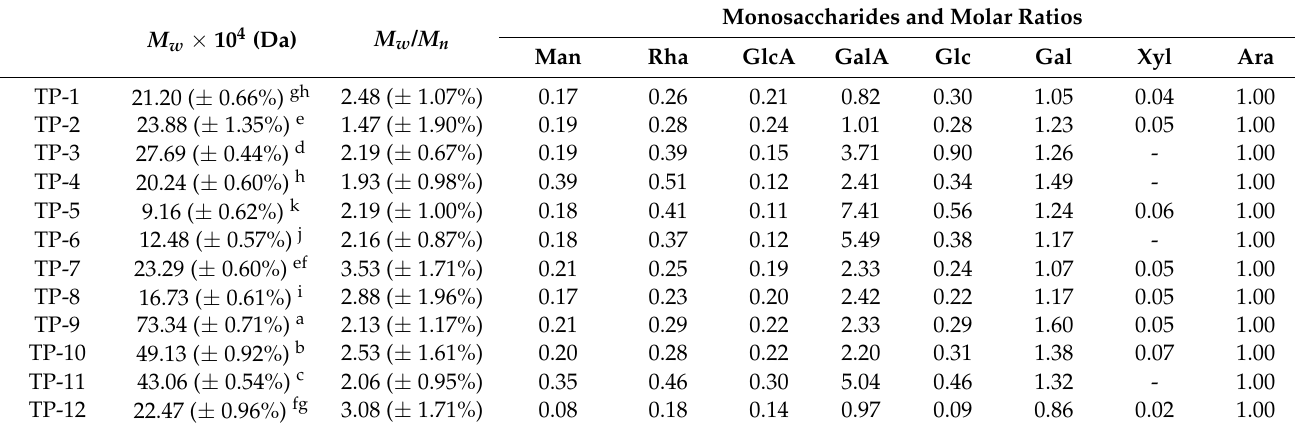
Table 3. Molecular weight ( M w ), polydispersity ( M w /M n ), and molar ratios of compositional monosaccharides of TPs. M w × 10 4